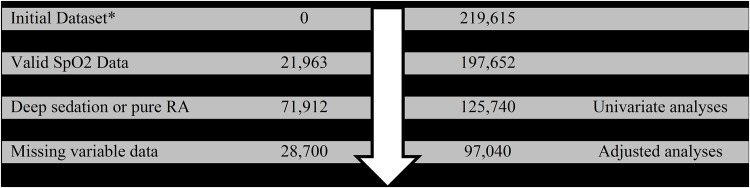
Study flow showing inclusions and exclusions.